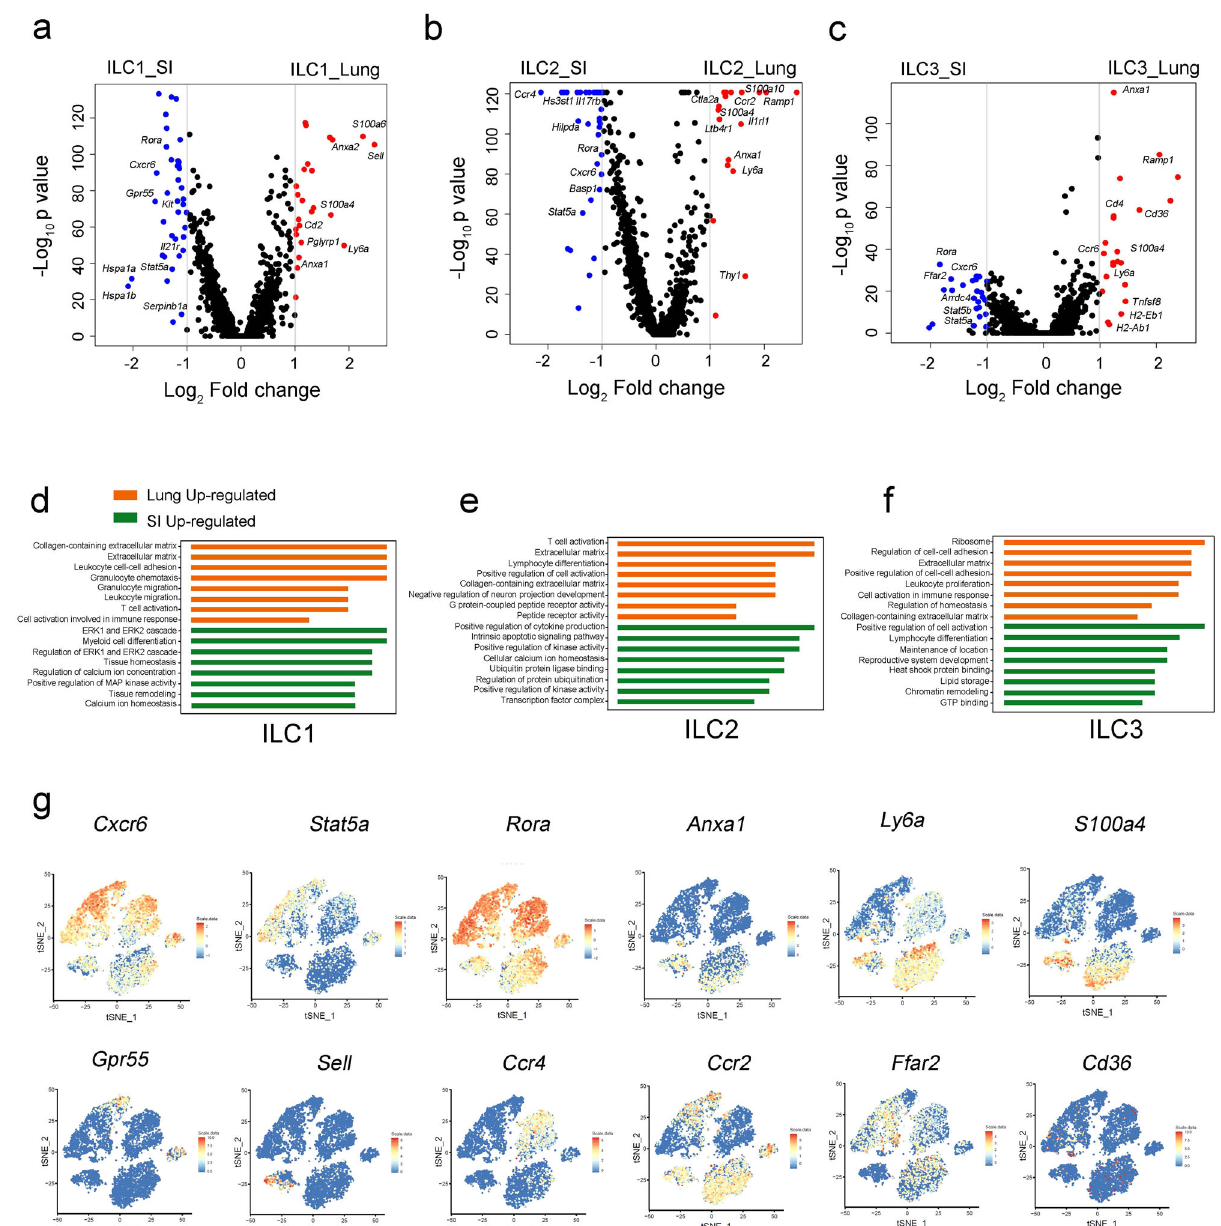
Fig.2|Differentiallyexpressedandtissuespeci fi cgenesofILCsinthelungand smallintestine.a – c DifferentialgeneexpressionofILCsubsetsinthelungandthe gut was analyzed and shown in Volcano plot. Statistical analysis was performed by using two-tailed unpaired Student ’ s t -test. Red dots represented the genes highly expressed inthelung,andbluedotsrepresentedthegeneshighlyexpressedinthe gut. d – f GO analysis of differentially expressed genes in the lung and the gut. The orange bars showed the pathways that were enriched in the lung, and the green